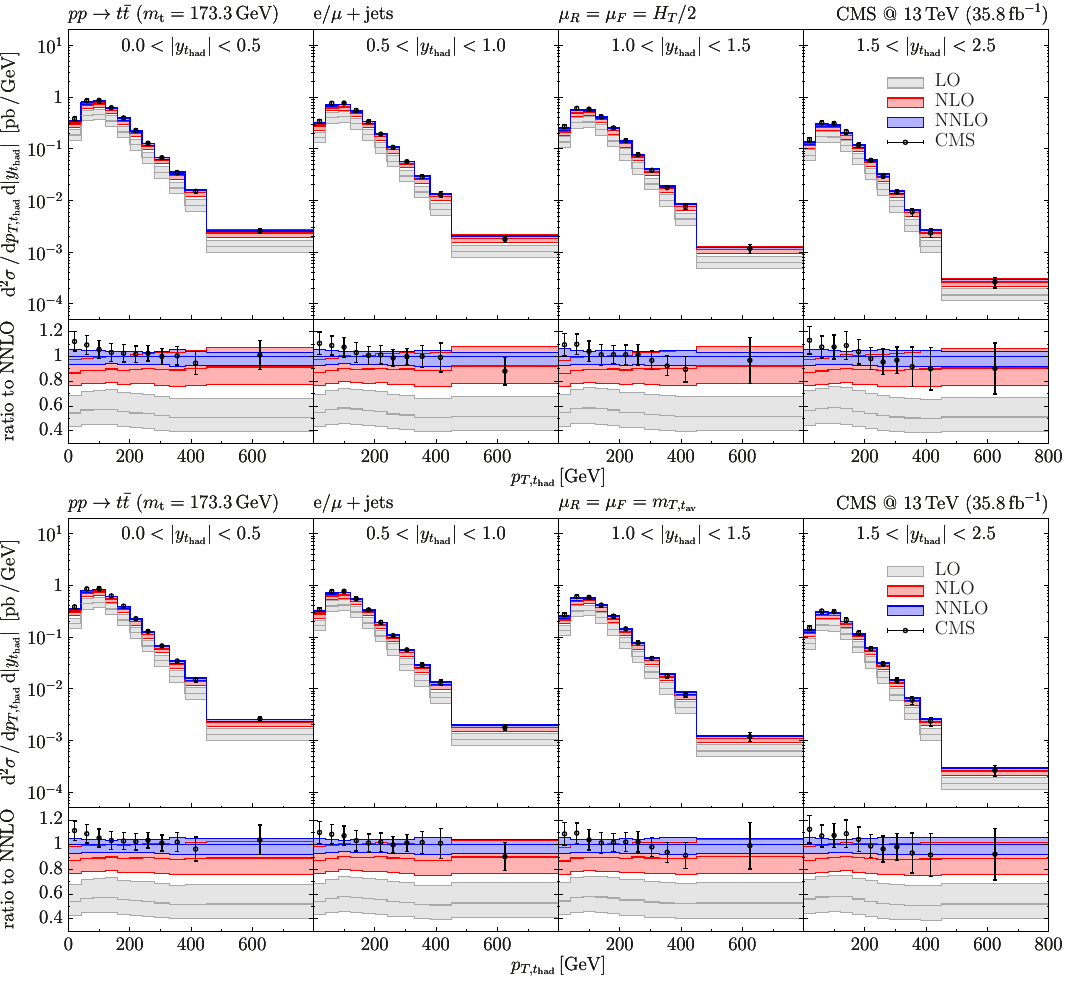
Figure 7 . Double-di(cid:11)erential cross sections as a function of p T;t data [9] and LO, NLO and NNLO results for central scales H T = 2 (upper) and m T;t